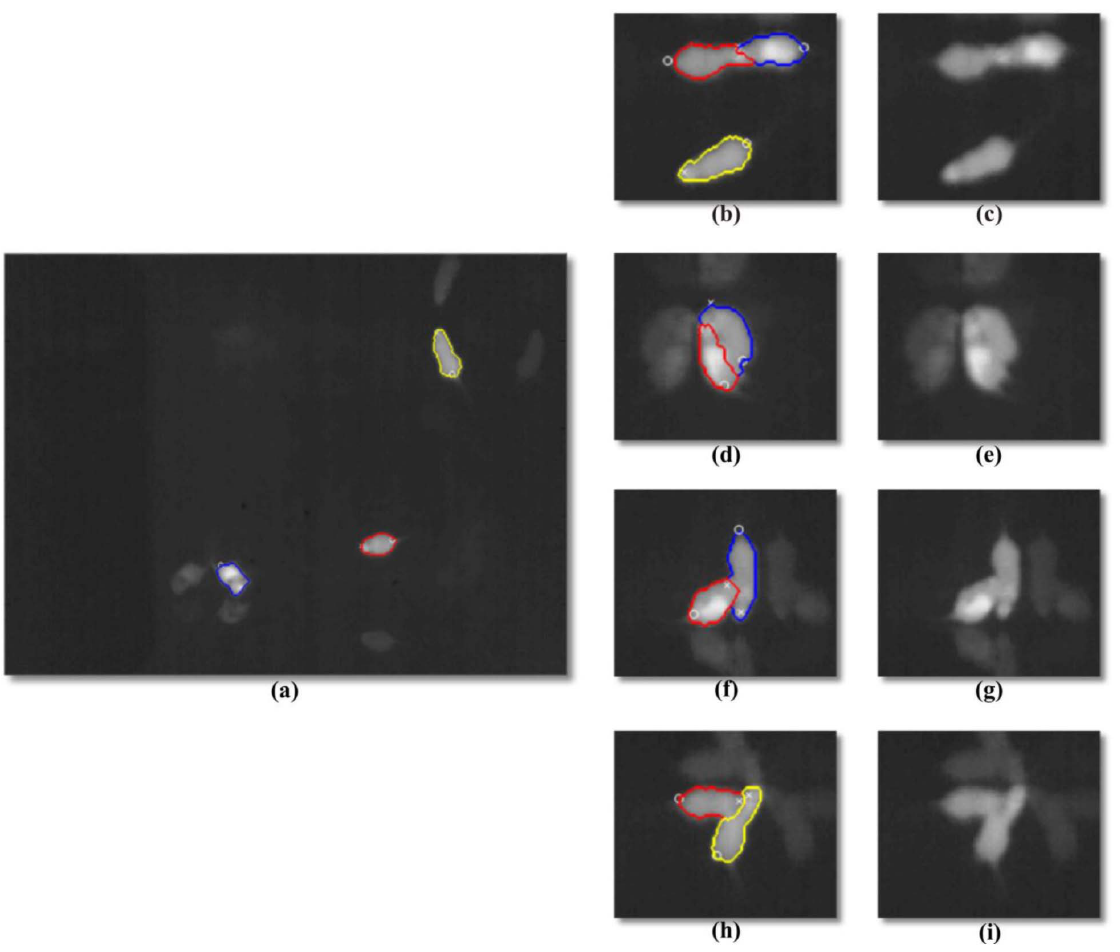
Figure 3. Examples of challenging mice interactions. The red, blue and yellow lines represent the contours detected by the tracking algorithm. (a) The whole mice arena; (b,d,f,h) details of the algorithm output; (c,e,g,i) unprocessed IR details.